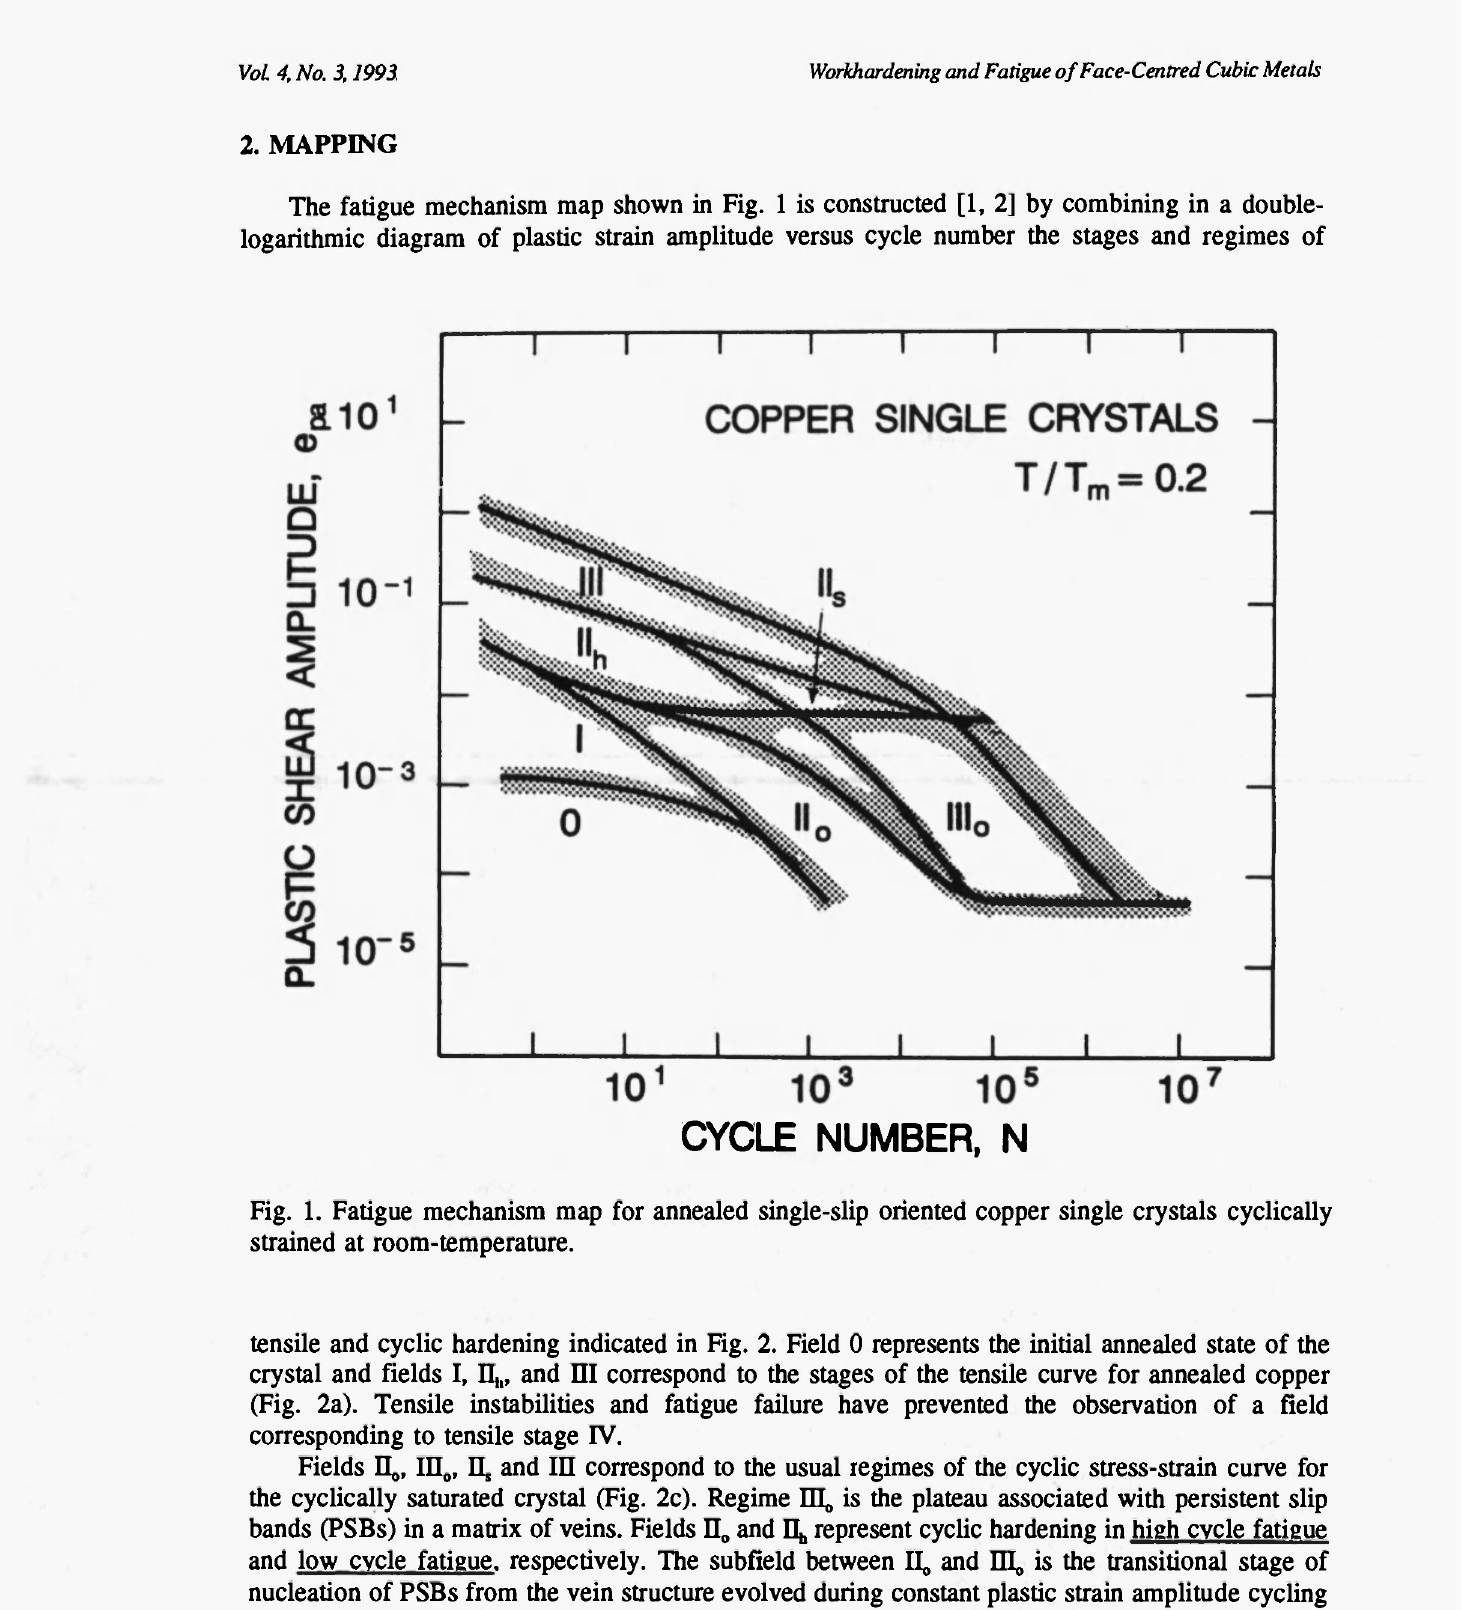
Fig. 1. Fatigue mechanism map for annealed single-slip oriented copper single crystals cyclically strained at